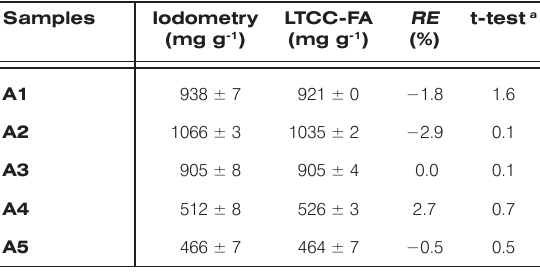
Table 3. Determination of AA in pharmaceutical formulations using the LTCC-FA and iodometric